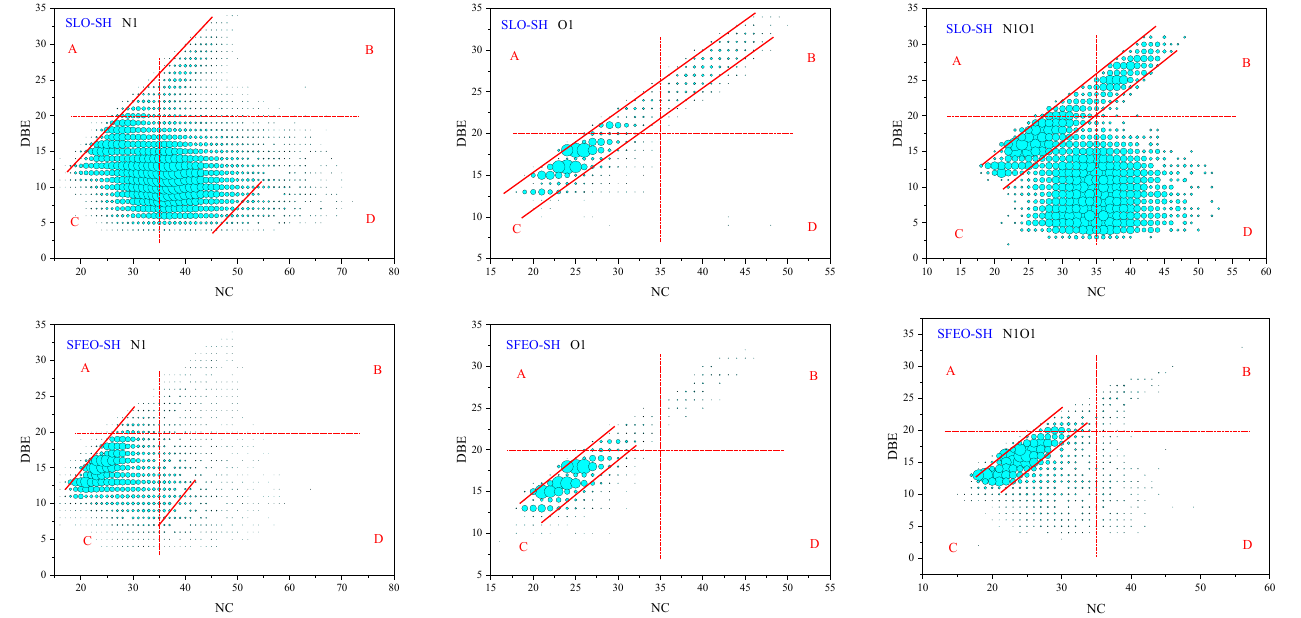
Figure 12. NC-DBE distribution of compounds in SLO–LH and SFEO–LH detected by FT-ICR MS (+ESI). (NC, number of carbon; DBE, double bond equivalents. The NC and DBE regions of N1, O1, and N1O1 compounds are demarcated at 35. The DBE regions of N1, O1, and N1O1 compounds are demarcated at 20. For example, N1 compounds in the A region (NC < 35 and DBE > 20)).